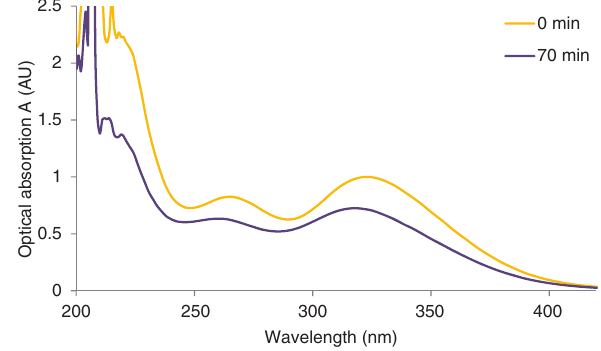
Figure 2 Absorption spectra of Pd RadChem NPs (Dose = 30 kGy) in reversed micellar solutions at different values of ω